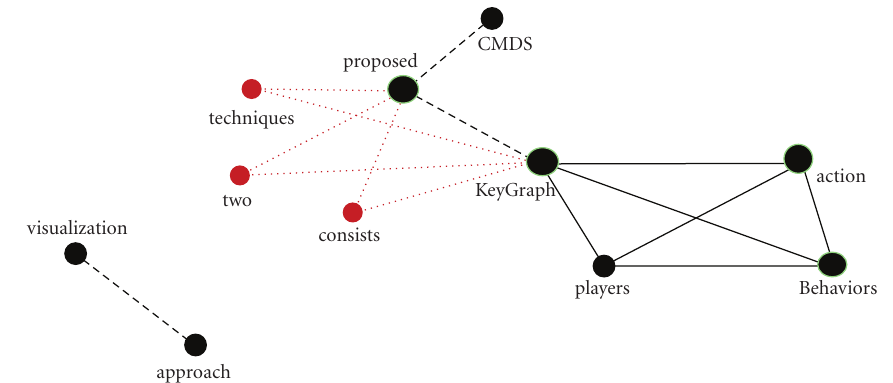
Figure 3: KeyGraph applied to the abstract of this